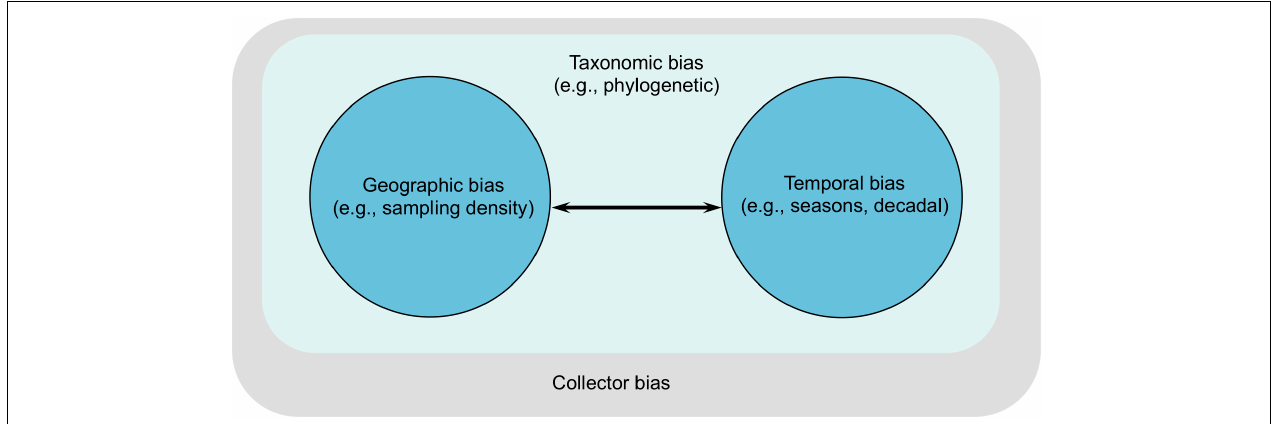
FIGURE 2 | Interactions between sampling biases indicating the extent of influence of each bias on the others. Taxonomic bias affects all other biases whereas arrows indicate direction of influence between the other two. However, all three types of biases ultimately reflect the personal preferences, biases, and proclivities of